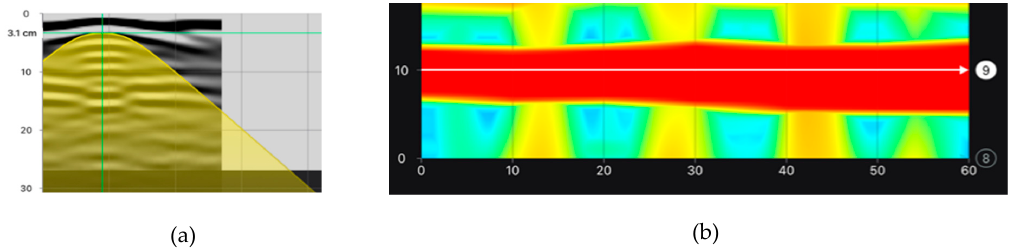
Figure 17. Scans taken with the radar (3), one rebar detected, ( a ) line scan (radargram—measurement at the point shown in Figure 10d), ( b ) area scan (measurement on the surface shown in Figure 10b)